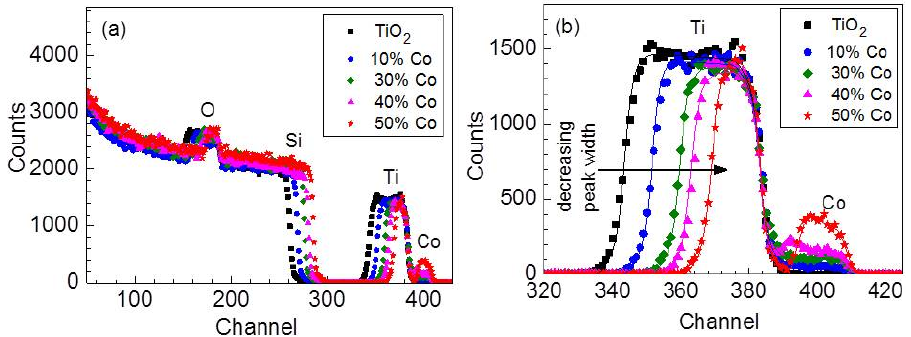
Figure 1. ( a ) Rutherford backscattering spectrometry (RBS) spectra; and ( b ) Ti and Co RBS signals for the TiO 2 and Cobalt-doped TiO 2 (CTO) thin films doped with Co concentrations of 0, 10, 20, 30, 40, and 50% by volume of CoCl 2 dopant solution.